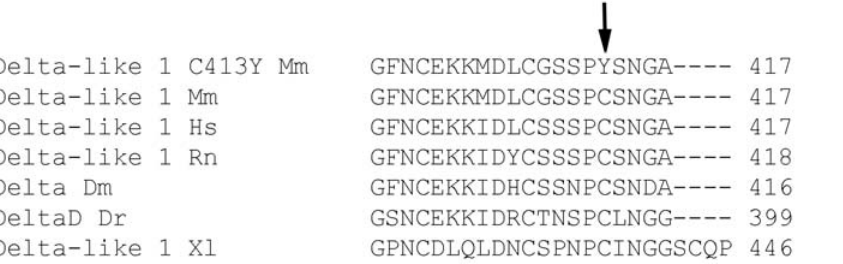
Figure 6. Partial protein sequence alignment of Delta and Delta-like-1 proteins. The sequence alignment was performed with ClutsalW2 [90]. The missense mutation C413Y is indicated by an arrow. The species used for these alignment are: Delta-like 1 Mm, Delta-like 1 Mus musculus NP_031891.2; Delta-like 1 Hs, Delta-like 1 Homo sapiens NP_114452.1; Delta-like 1 Rn, Delta-like 1 Rattus norvegicus NP_005609.3; Delta Dm, Delta Drosophila melanogaster NP_477264.1; DeltaD Dr, DeltaD Danio rerio ; Delta-like 1 Xl, similar to Delta-like 1 Xenopus laevis . doi:10.1371/journal.pone.0006054.g006 PLoS ONE |